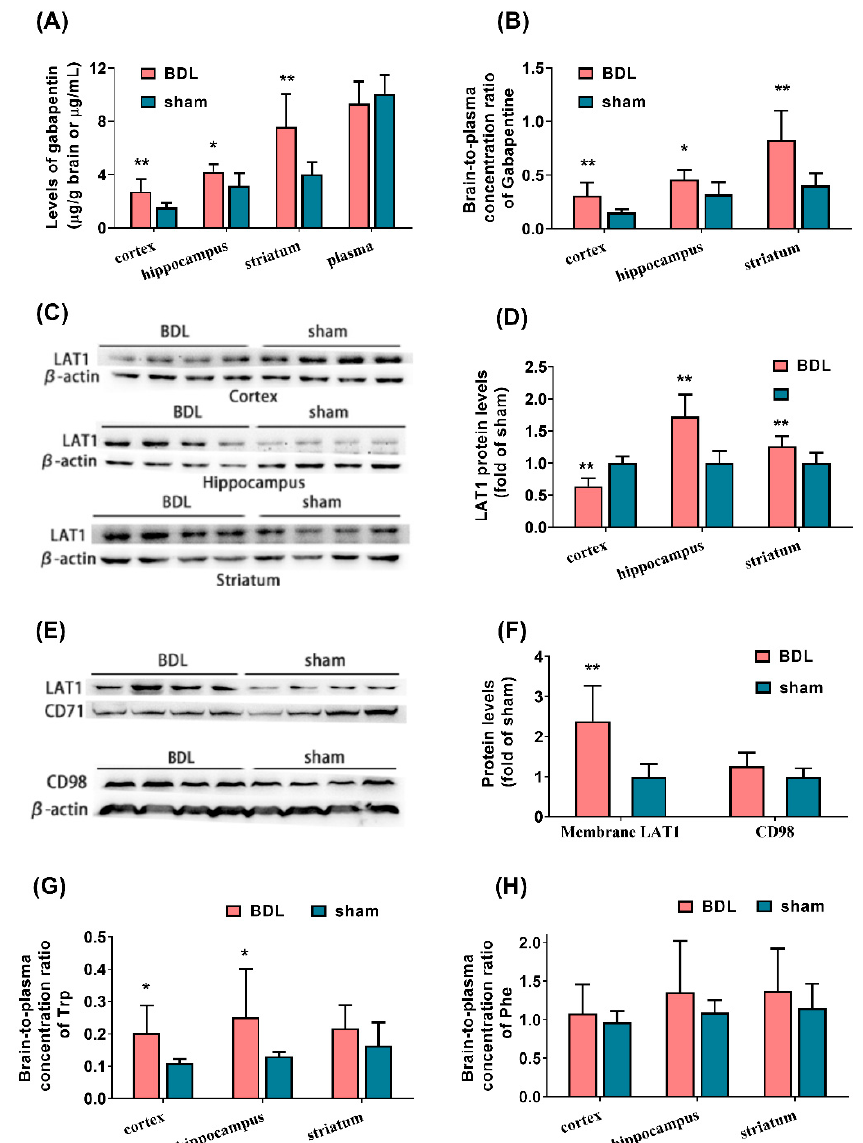
Figure 1. Effects of BDL on function and expression of LAT1 in brain tissues of rats. Concentrations of gabapentin in the cortex, hippocampus, striatum, and plasma of rats ( A ) and the brain-to-plasma concentration ratio of gabapentin ( B ). Levels of total LAT1 protein ( C , D ) in the cortex, hippocampus, and striatum of rats. Levels of CD98 and membrane LAT1 protein in cortex of rats ( E , F ). The brain-to- plasma concentration ratio of Trp ( G ) and Phe ( H ) in cortex, hippocampus, and striatum of rats. Data are presented as the mean ± SD ( n = 8). * p < 0.05 and ** p < 0.01 versus sham rats. The protein levels of LAT1 in the cortex, hippocampus, and striatum of BDL rats were further detected using western blotting. It was found that the BDL